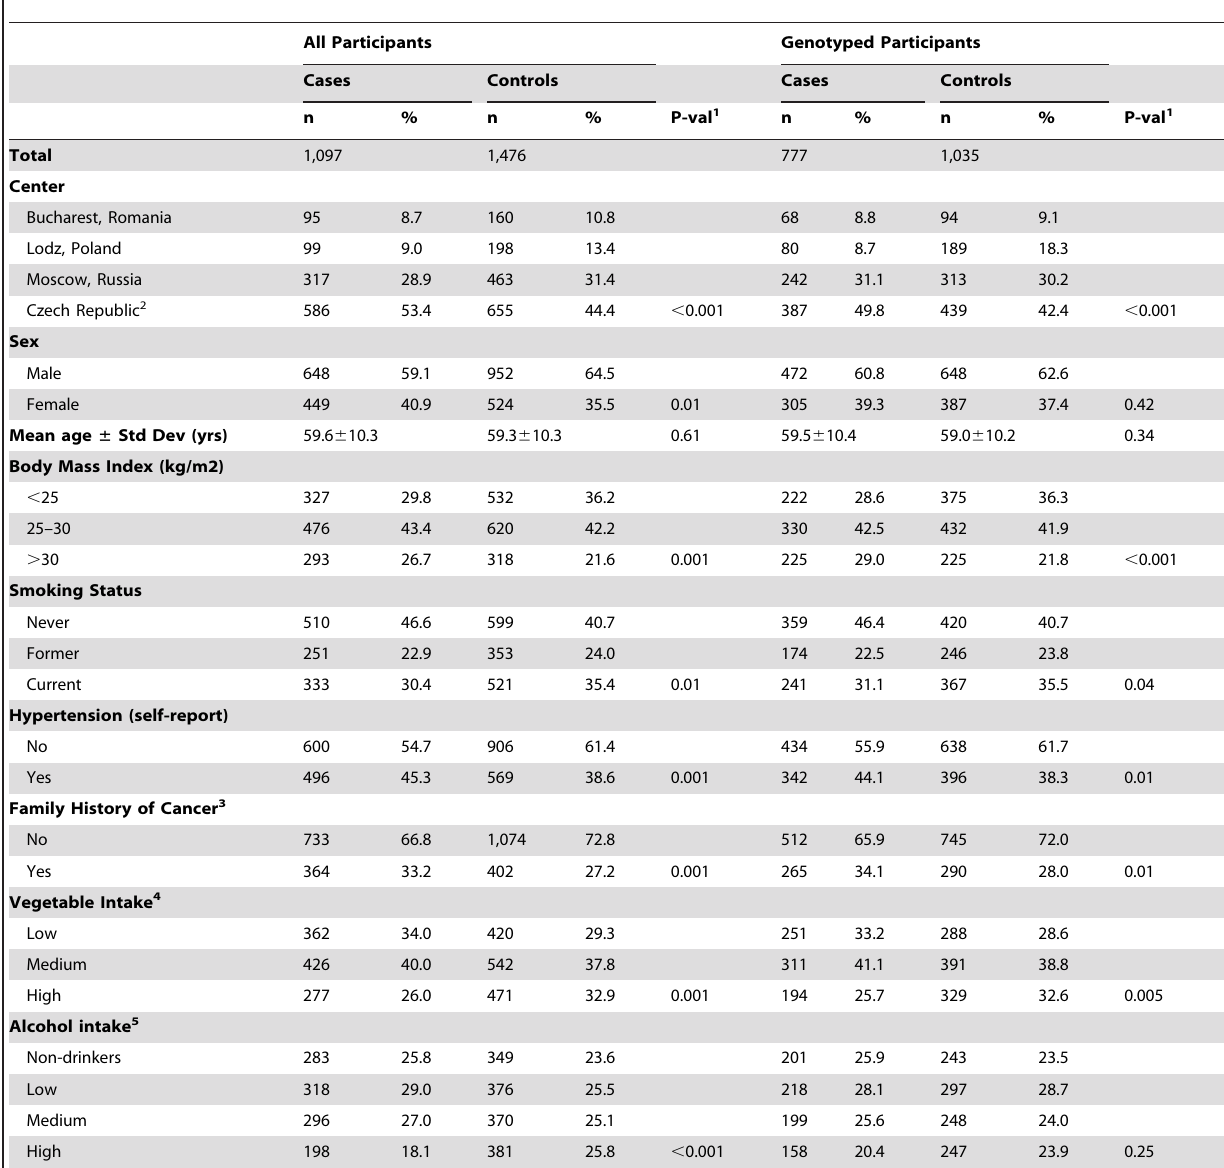
Table 2. Demographic and lifestyle characteristics of participants in the Central and Eastern European Renal Cell Cancer Study.